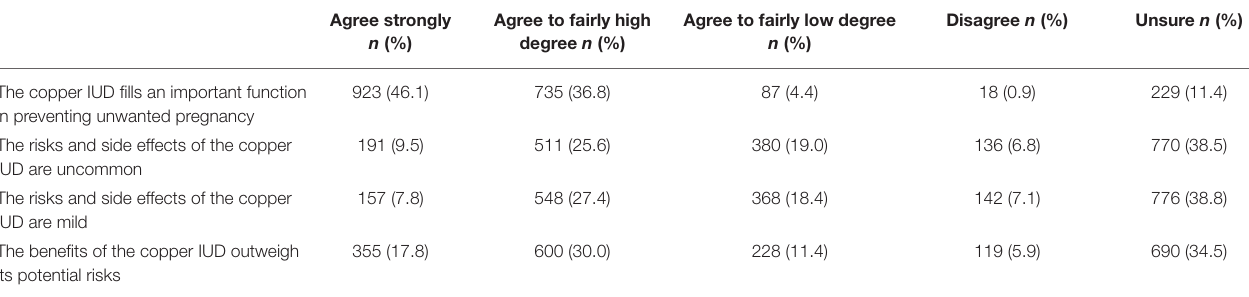
TABLE 2 | Perceived risks and benefits of the copper IUD.